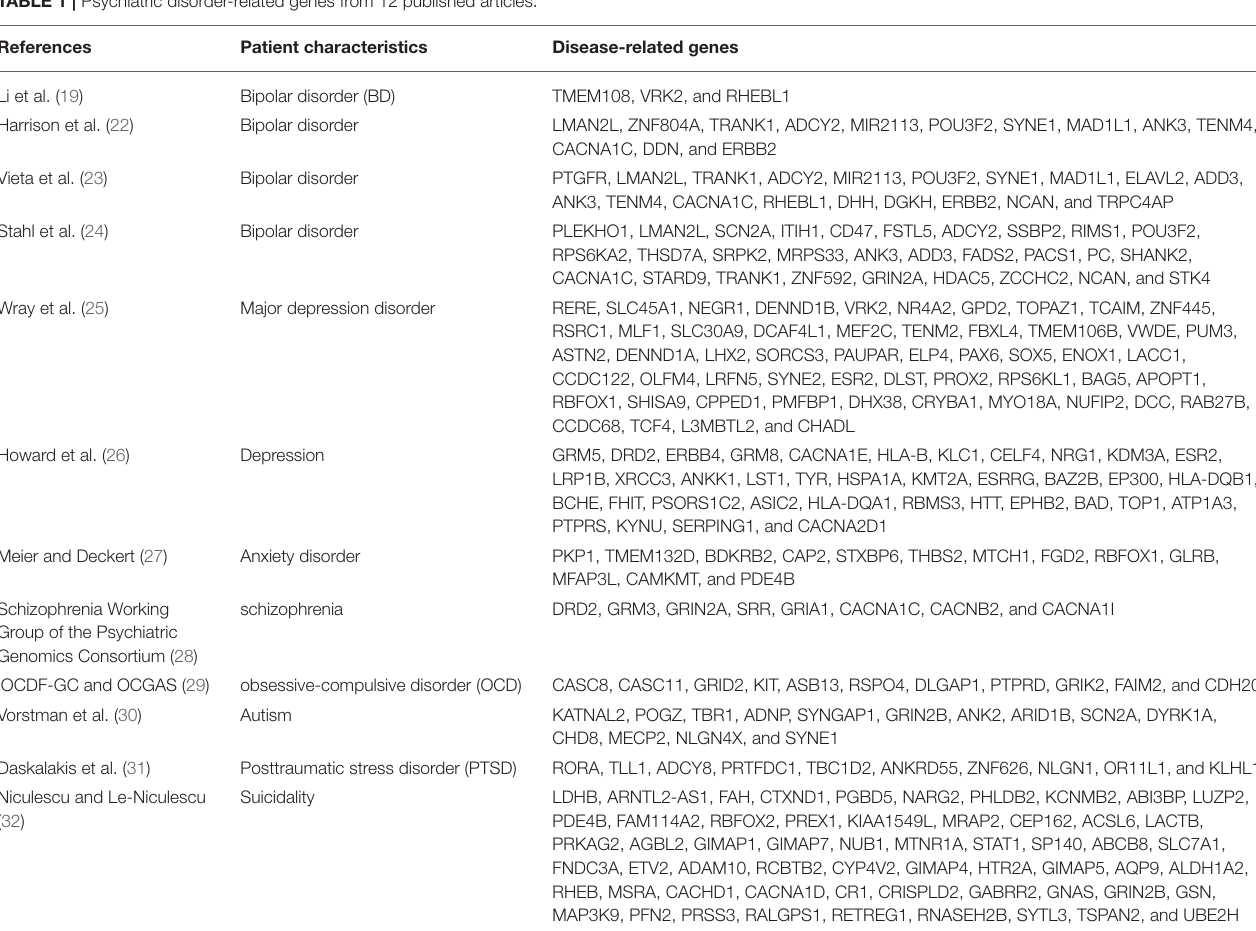
TABLE 1 | Psychiatric disorder-related genes from 12 published